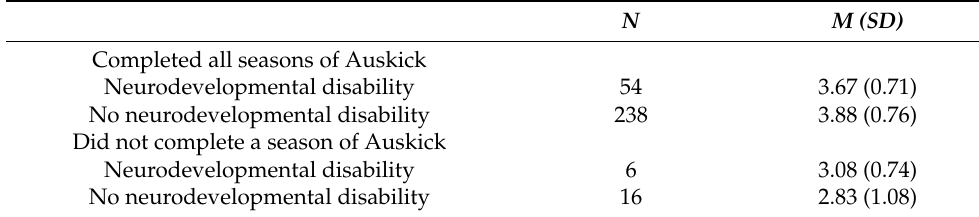
Table 5. Means and standard deviations on child connection to